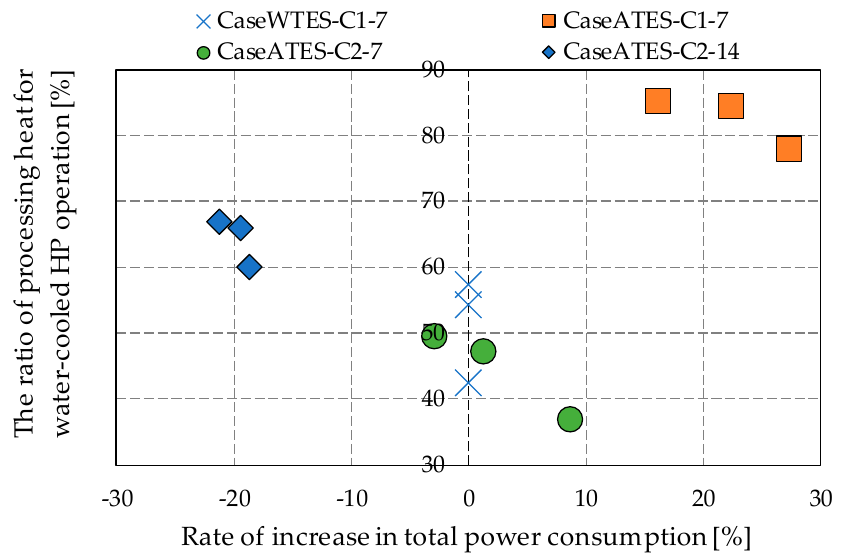
Figure 13. Processing heat ratio of the water-cooled HP in cooling operation and rate of increase in total power consumption.